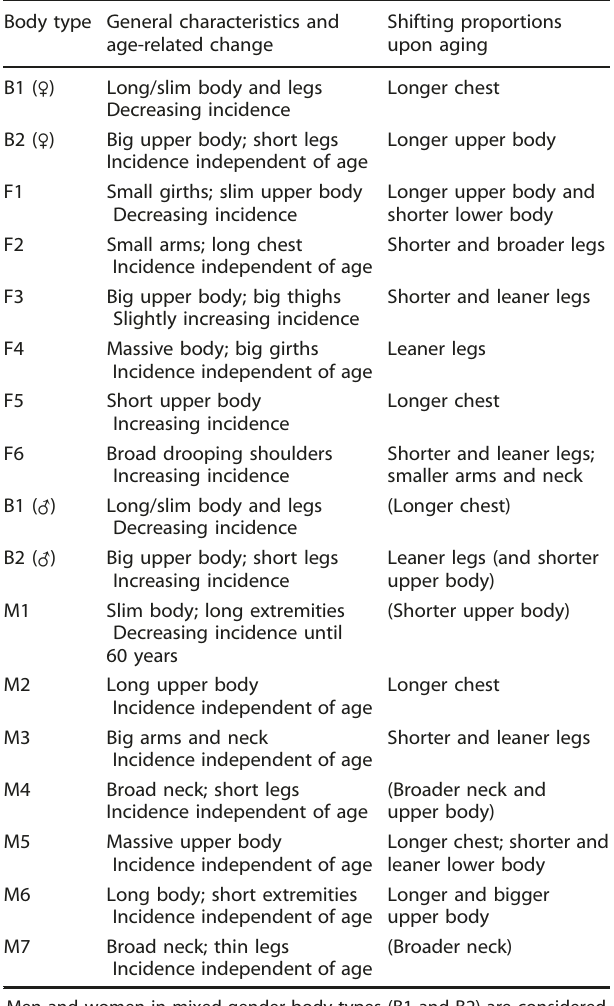
Table 2. List of body types and associated characteristics of body